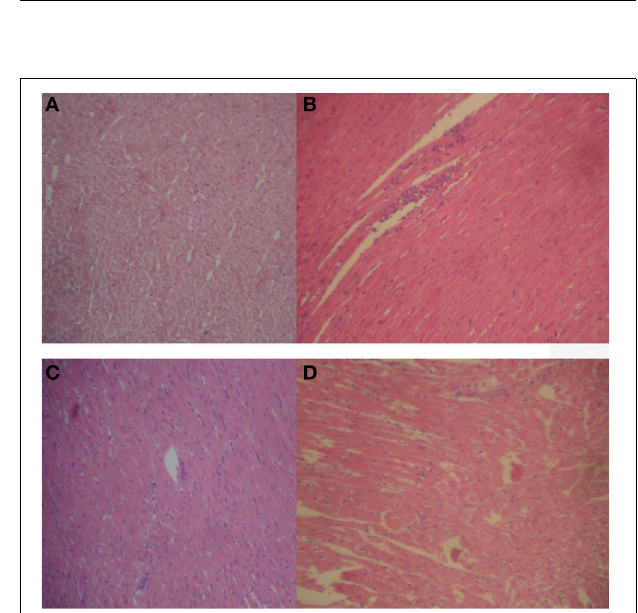
FIGURE 1 | Representative sections of rat lungs in respect of 30 days treatment. (A) Normal rat lung showing normal alveoli and lung parenchyma; (B) 20mg/kg/day HLE-FP-treated lung showing hyperplasia of the alveolar septae resulting in thickened alveolar space; (C) 100mg/kg/day HLE-FP-treated lung showing alveolar space smaller than that of control; and (D) 500mg/kg/day HLE-FP-treated lung showing alveolar space remarkably smaller than that of control ( × 100 magnification).